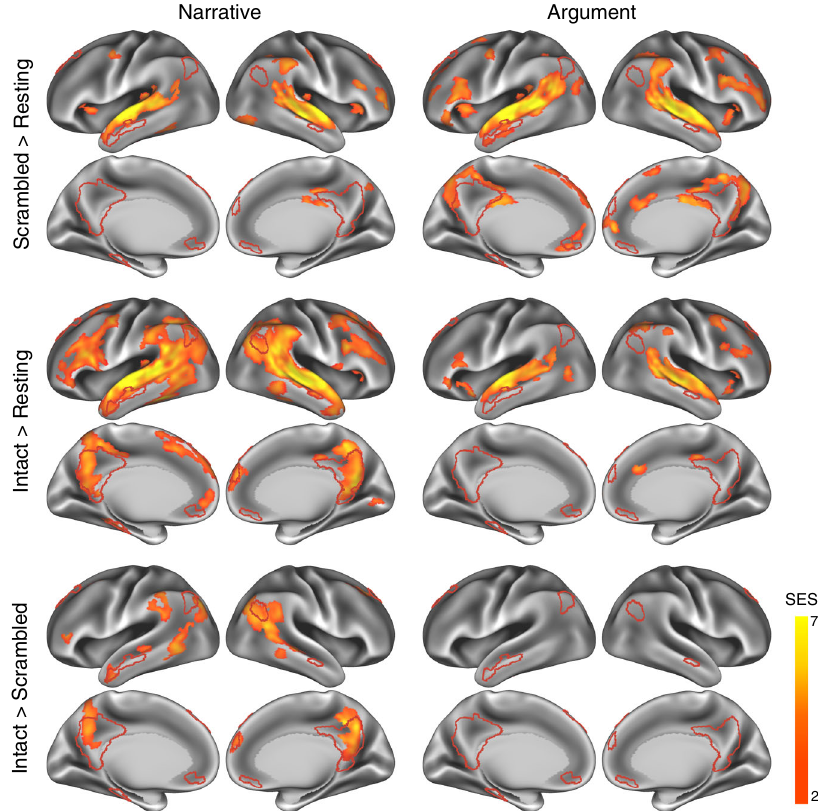
Fig. 3 Narrative, not argumentative texts, induced time-locked neural activity in the DMN. ISC contrast maps illustrate the signi fi cant areas of each contrast in the narrative (left) and the argumentative (right) conditions ( P < 0.05, FDR corrected, area >200 mm 2 ). The red borderline demarcates the territory of the DMN, de fi ned by the seed-based resting-state functional connectivity from the posterior cingulate cortex using the data from the participants in this experiment (Supplementary Fig. 2b; see “ Methods ” for details). The fi rst row shows the results of the contrast between the scrambled- sentence conditions and the resting-state condition. For both narrative and argumentative conditions, mainly the auditory, language, and domain-general systems were involved. The second row shows the results of the contrast between the intact-text conditions and the resting-state condition. While the neural distribution in the intact-narrative condition extended to other brain systems like the DMN, the neural distribution in the intact-argumentative condition was con fi ned to the areas in the scrambled-argumentative condition. The third row shows the results of the direct contrast between the intact- text condition and the scrambled-sentence condition. For the narrative condition, it only shows the areas that were also signi fi cant in the contrast between the intact-narrative condition and the resting state. Areas in the default mode, language, control, and attention systems were more engaged in the intact narratives. We did not fi nd any signi fi cant areas in this contrast for the argumentative condition. SES, standard effect